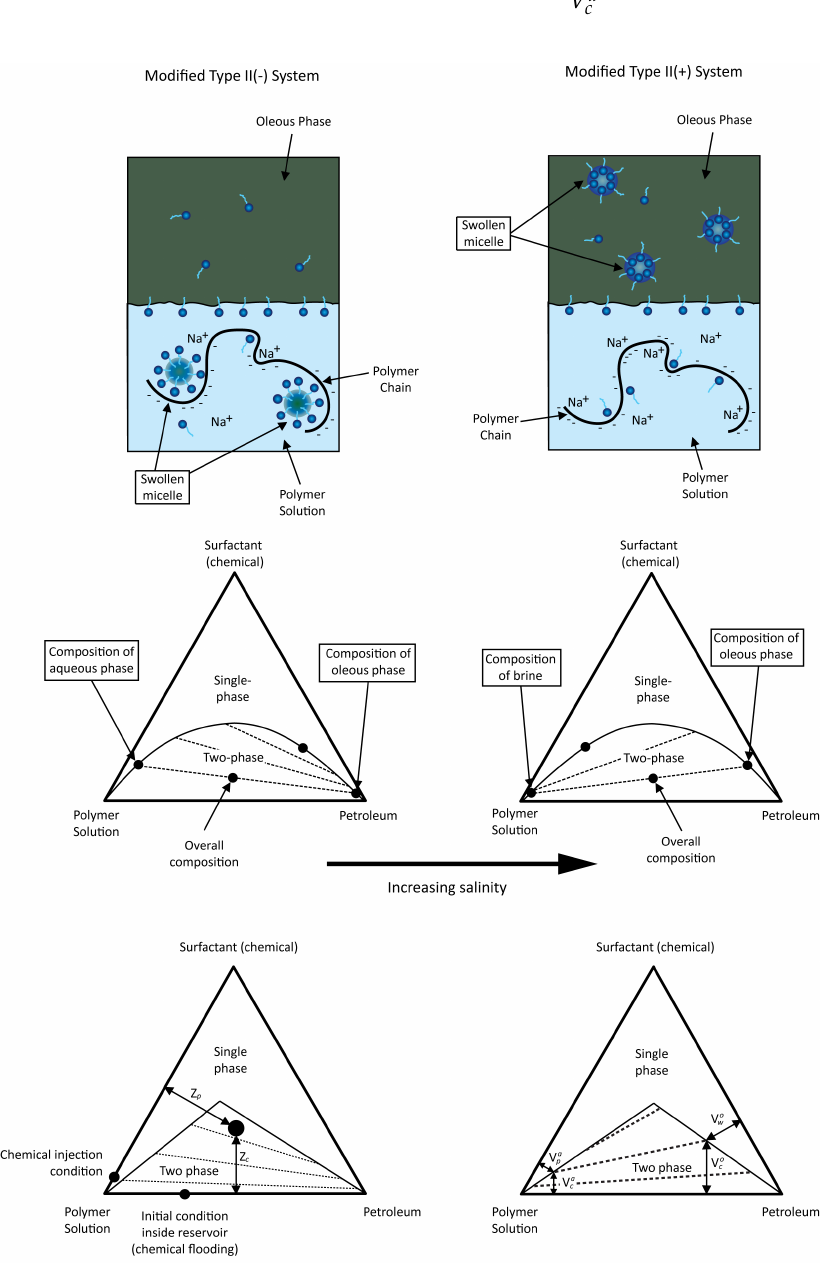
Figure 3. Ternary phase diagrams considering the polymer presence for type II( − ) ( left ) and II(+) ( right ) systems ( top ), and their simplifications for the simulations ( bottom ) (Adapted with permission from Druetta [28], Elsevier,